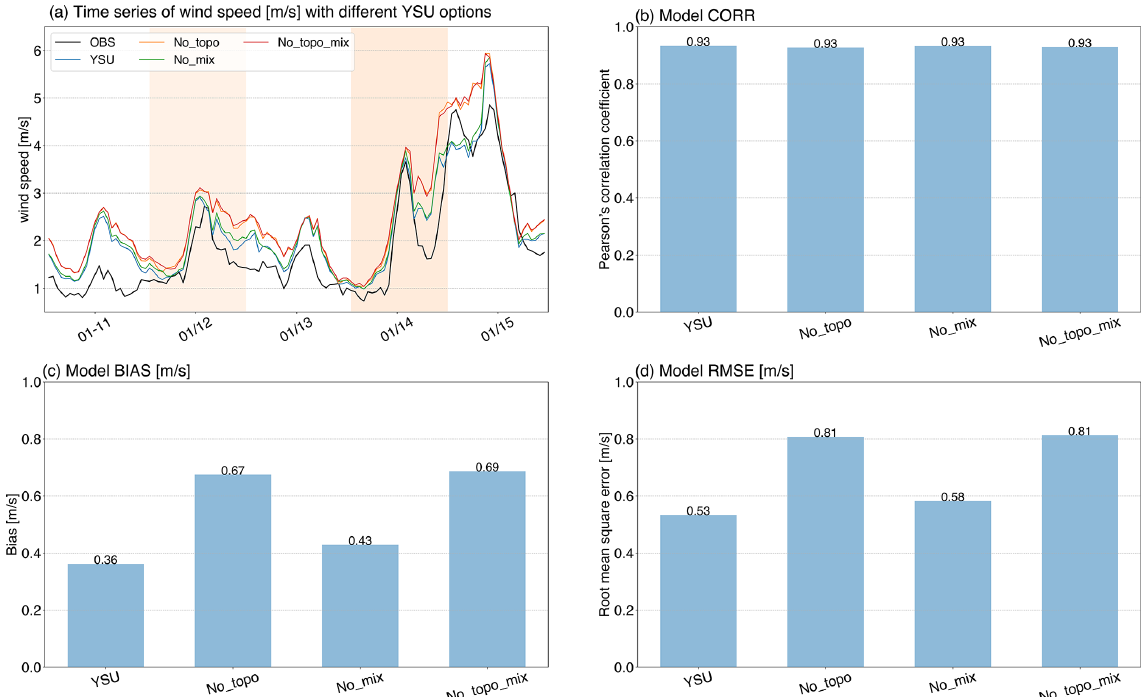
Figure 17. Same as Fig. 3 but for simulations with different YSU